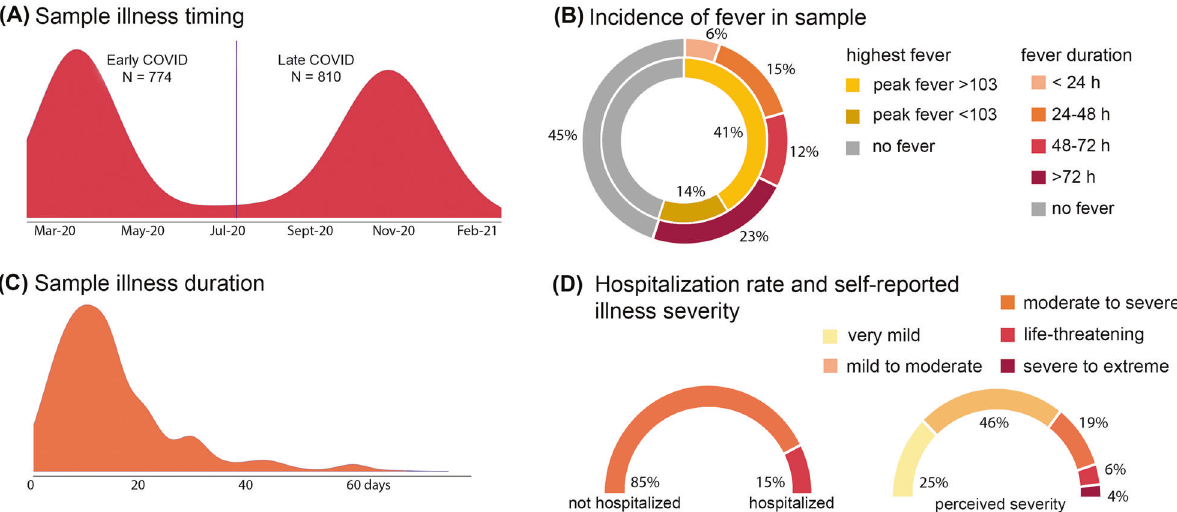
Fig. 5 Overview of illness severity in current sample of N = 1584 adults infected with COVID-19. Quality validated data were used to generate descriptive statistics that summarize illness timing ( A ); frequency and extent of fever ( B ); duration of illness ( C ); and both rate of hospitalization and self-reported illness severity in our adult sample ( D ). Bimodal distribution in A aligns well with observed incidence in New York City over this time period. The vertical line in A is the mean cut point used to analyze potential differences in early versus late infection